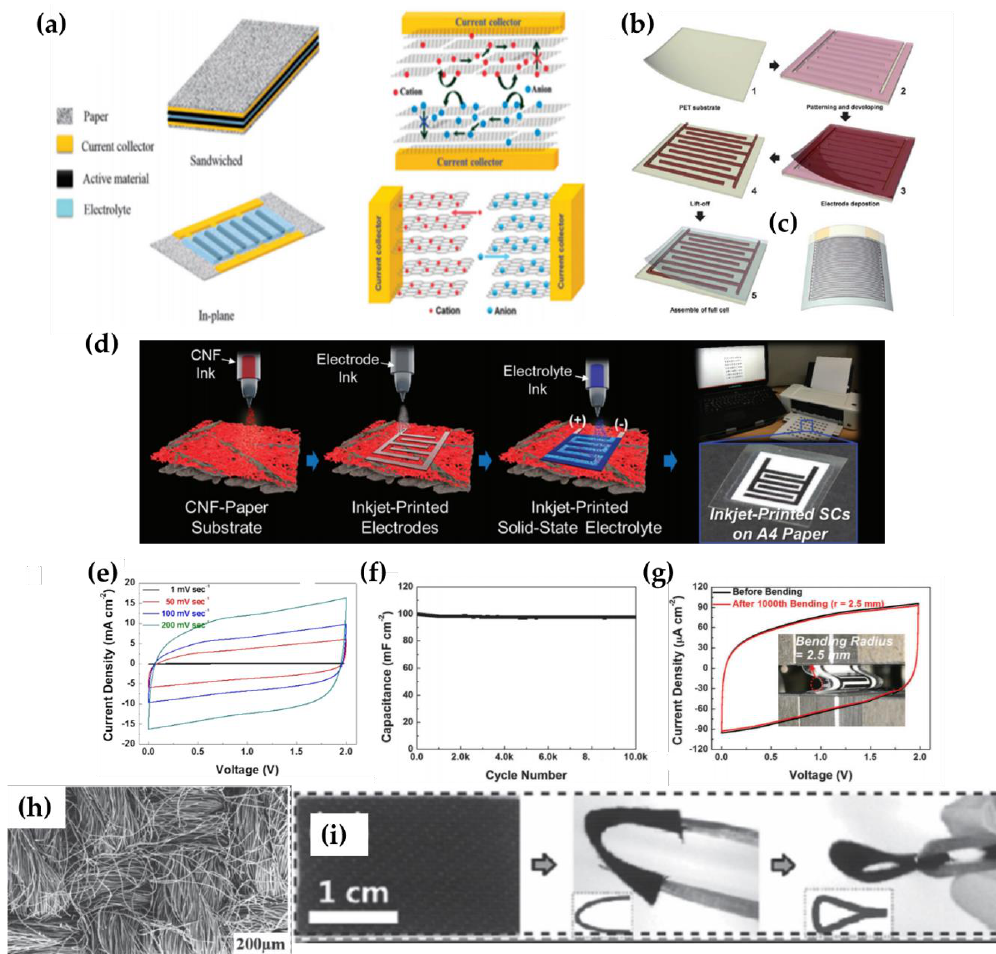
Figure 1. ( a ) Illustration of paper type SCs with a traditional “sandwich” structure and a new “in-plane” structure. Diagram exhibiting the ion transfer associated with the operation of both types of supercapacitors (SCs). Adapted with permission from [17]. Copyright (2015), The Royal Society of Chemistry 2015. ( b ) Process flow for producing transparent, super-bendable supercapacitor without percolation. ( c ) Schematic of a transparent, ultra-bendable supercapacitor with alternating patterned electrodes. Adapted with permission from [17]. Copyright (2013), The Royal Society of Chemistry 2013. ( d ) Manufacturing of inkjet-printed SCs with different fabrication factors. Schematic diagram of the stepwise manufacturing procedure of an inkjet-printed SC. ( e ) Cyclic voltammetry (CV) profiles at various scan rates (1–200 mV/s). ( f ) Cycling performance of inkjet-printed SC at a constant charging-discharging current density (0.2 mA/cm 2 ). ( g ) CV tests of inkjet-printed SC (scan rate of 1.0 mV/s) after repetitive folding deformation (folding radius from 2.5 mm to 1000 cycles) [22]. Copyright (2016), The Royal Society of Chemistry 2016. ( h ) SEM image of activated carbon fiber cloth (ACFC). ( i ) ACFC based textiles are bent with a plastic tube of diameter 8.5 mm. Adapted with permission from [31]. Copyright (2015), WILEY-VCH Verlag GmbH & Co. KGaA, Weinheim.